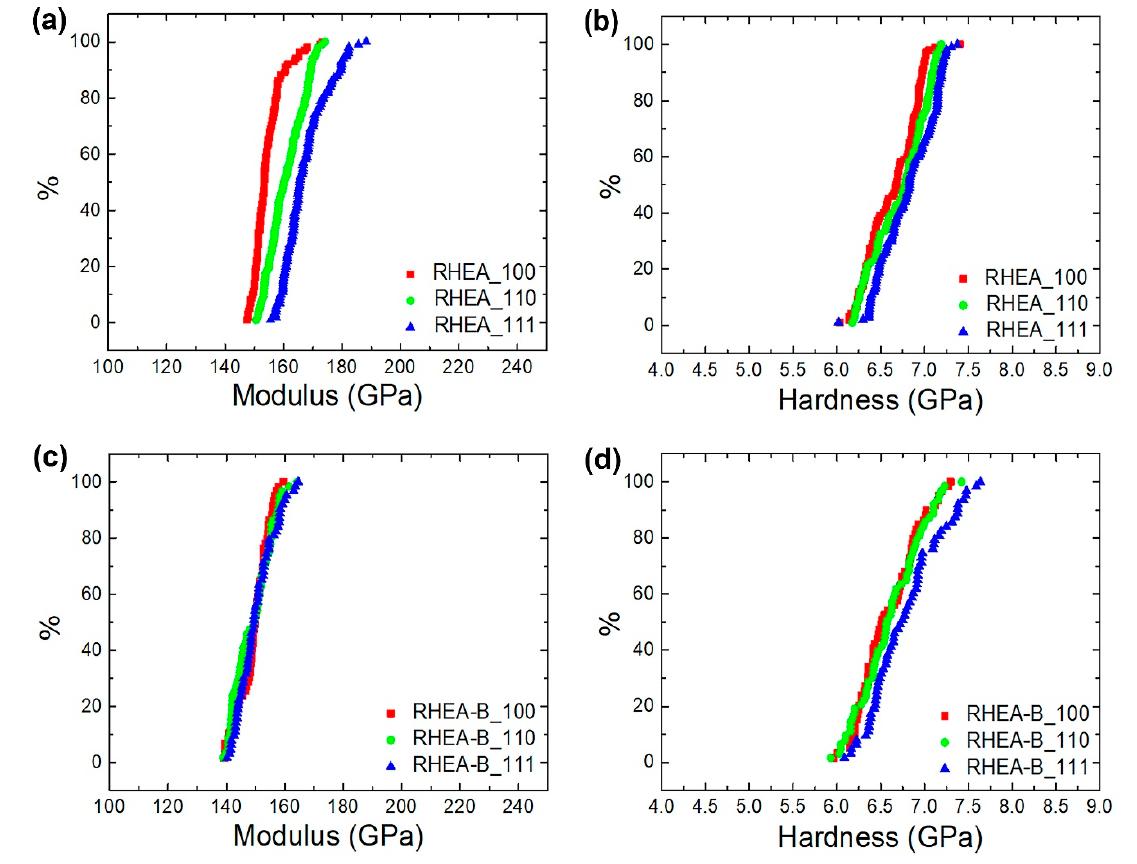
Figure 5. Accumulative plots of nanoindentation modulus and hardness for the (cid:104) 100 (cid:105) , (cid:104) 110 (cid:105) and (cid:104) 111 (cid:105) grains of RHEA and RHEA-B samples: ( a ) modulus of RHEA, ( b ) hardness of RHEA, ( c ) modulus of RHEA-B, ( d ) hardness of RHEA-B.